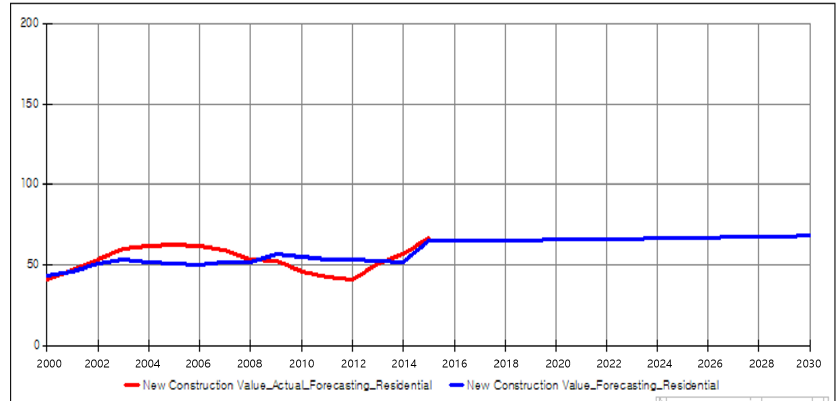
Figure 7. Forecasting results of scale forecasting model in construction market.